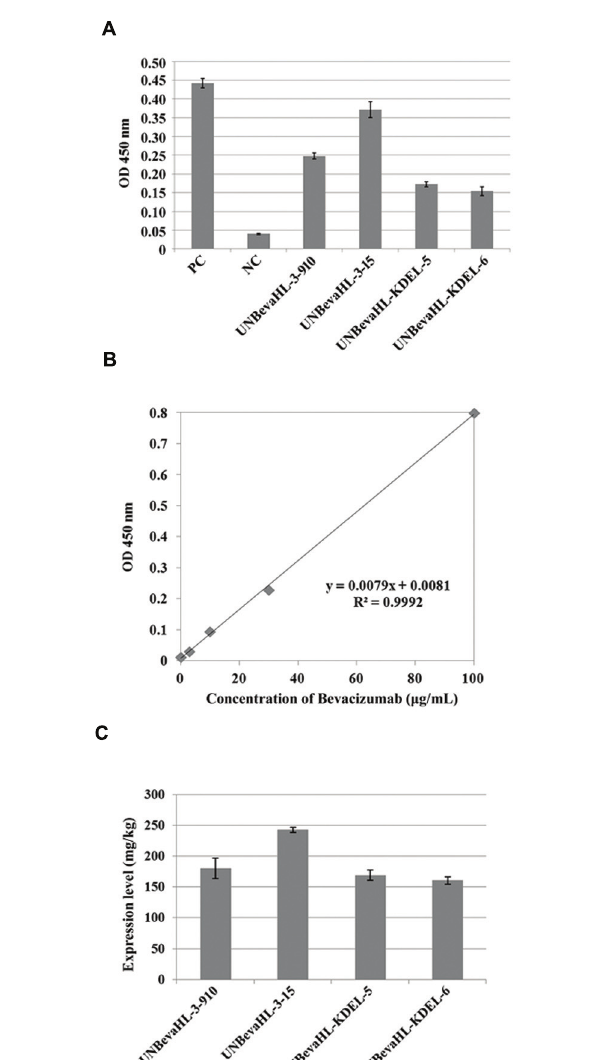
FIGURE 3 | Functional analysis of plant expressed Bevacizumab mAb and qualification of the expression levels in transgenic plants by ELISA. (A) The binding activity of rice-derived Bevacizumab to hVEGF antigen was determined by ELISA with a positive control of the commercial Bevacizumab mAb and a negative control of non-transformed plants. Two transgenic lines each from pUNBevaHL and pUNBevaHL-KDEL transformed plants were analyzed in triplicates. (B) Standard curve of Bevacizumab. (C) mAb expression levels in transgenic plants. The experiment was performed in triplicates, and the means and errors of mAb contents in different transgenic plants were presented in graph.